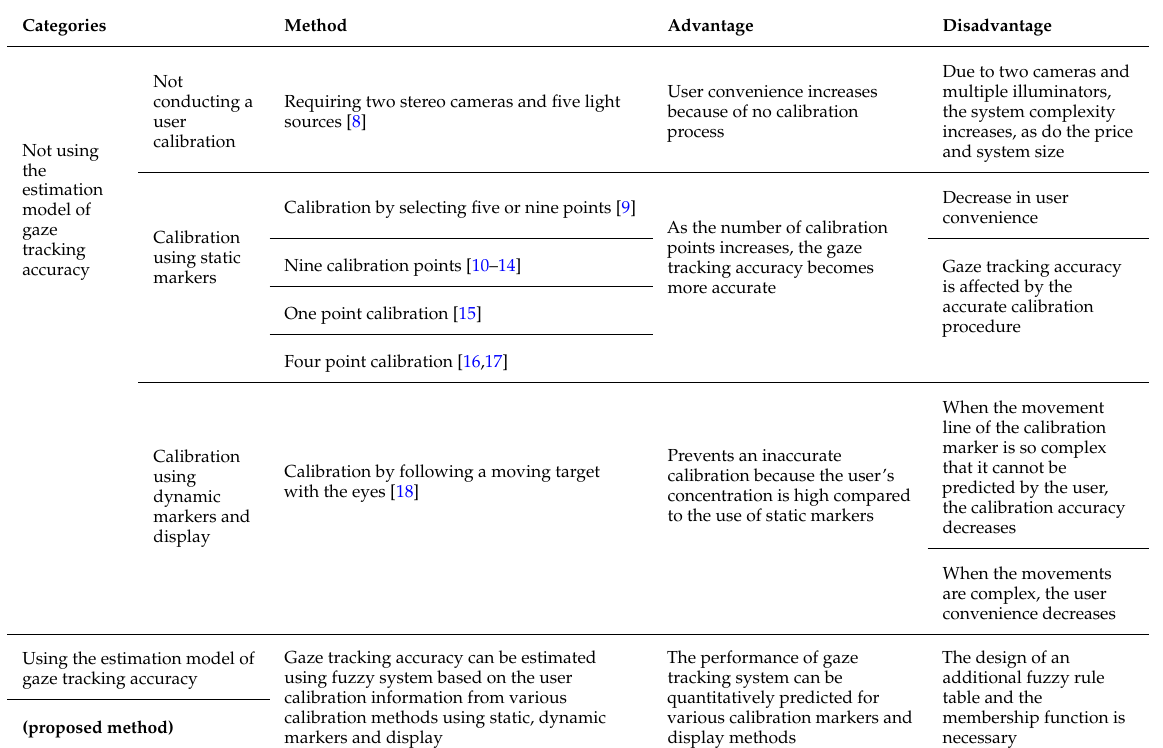
Comparison of the advantages/disadvantages between previous studies and the proposed